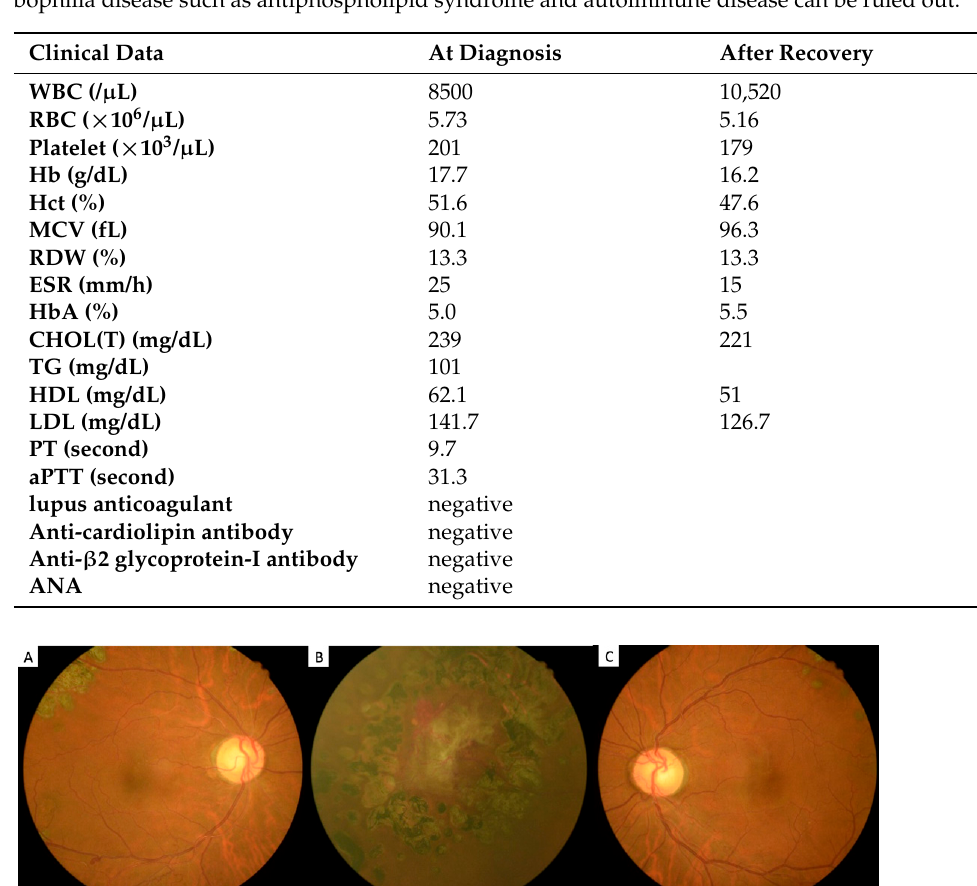
Figure 4. ( A ) Tortuous retinal artery and venous sheathing in the right eye; ( B ) Fibrovascular membrane with hemorrhage surrounded with laser scar in the right eye; and ( C ) Tortuous retinal artery in the left eye.